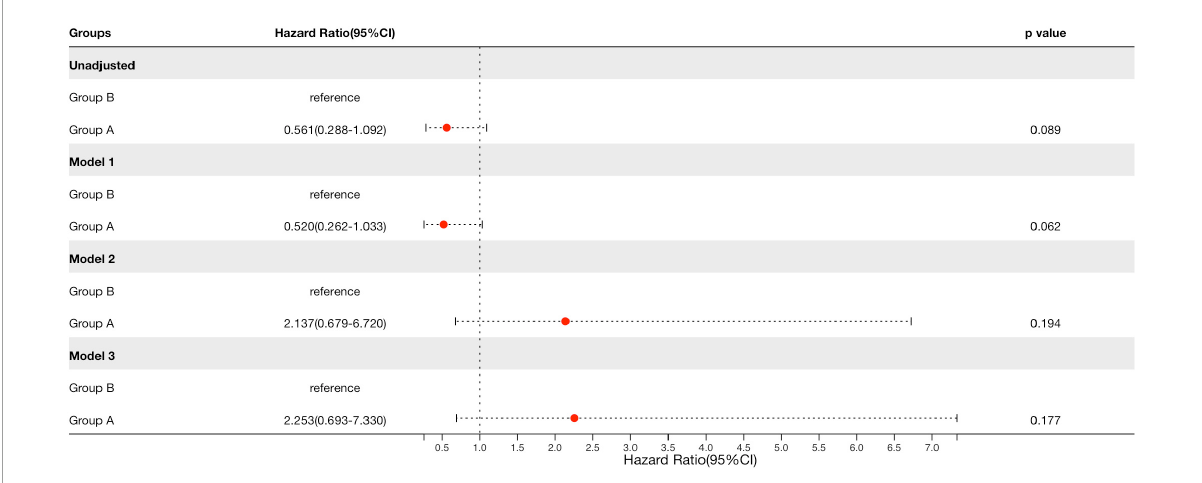
FIGURE4 Cox regression to compare the prognosis between the arteriolar lesions group and proliferative lesions group in patients with IgAN. Group A, arteriolar lesion group; Group B, proliferative lesion group. Model 1 was adjusted for sex and age. Model 2 was adjusted for covariates in model 1 plus eGFR, proteinuria, history of hypertension (yes or no), and Oxford classification-MESTC. The latter five variables were analyzed as categorical data. Model 3 was adjusted for covariates in model 2 plus RASI and steroids or other immunosuppressive agents use (yes or no). Renal survival in group A was not better than that in group B after adjustment for multiple clinical and histological risk factors, as well as therapy.